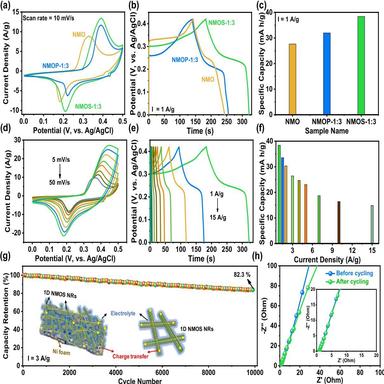
Comparison of (a) CV curves, (b) GCD curves, and (c) specific capacity values of NMOS-1:3 electrode with NMO and NMOP-1:3 electrodes. (d) CV curves and (e) GCD curves of NMOS-1:3 electrode at various scan rates and current densities, respectively. (f) Specific capacity values and (g) cycling stability of the NMOS-1:3 electrode. (h) EIS plots of the NMOS-1:3 electrode before and after the cycling test. Inset in (g) describes the structural benefits of NMOS-1:3 NRs.